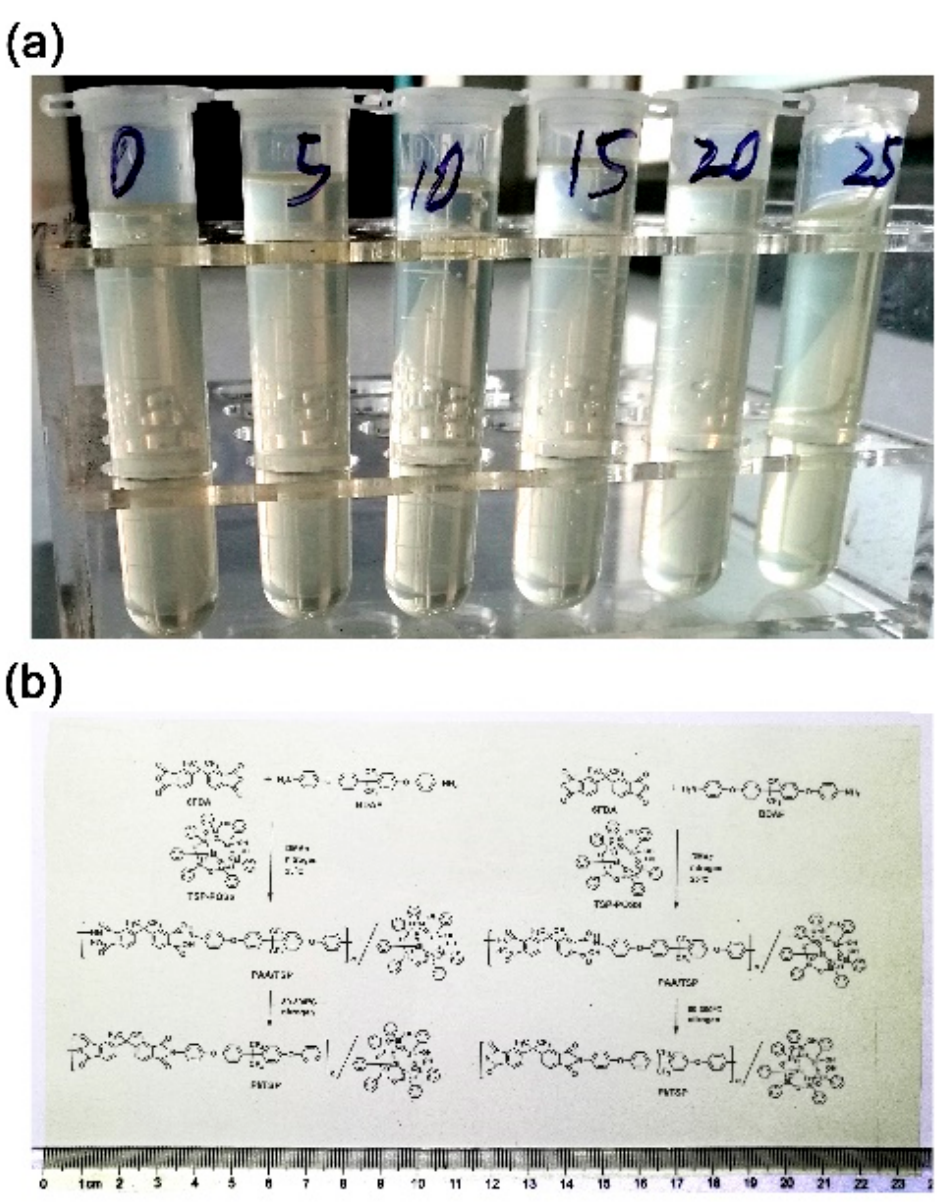
Figure 3. Appearance of polymers. ( a ) 6FPAA-X solutions (from left to right: 6FPAA-0, 5, 10, 15, 20, and 25); ( b ) 6FPI-25 composite film.